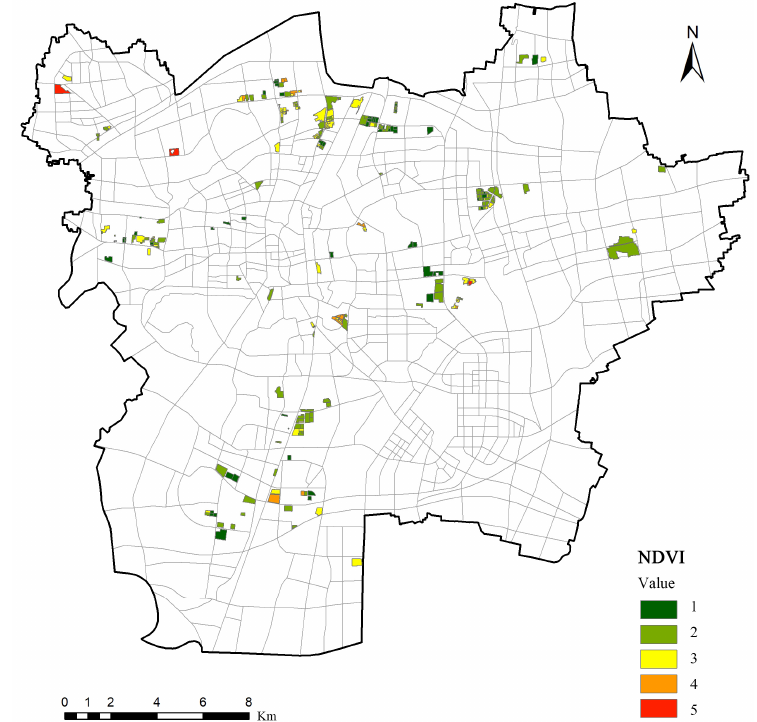
Figure A2. Single value of site suitability based on “NDVI”.